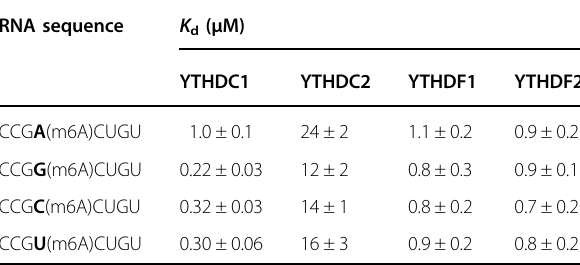
NB no binding. Table 2 Binding af fi nities of four human YTH family members (YTHDC1, YTHDC2, YTHDF1, and YTHDF2) to a 9- mer methylated RNA